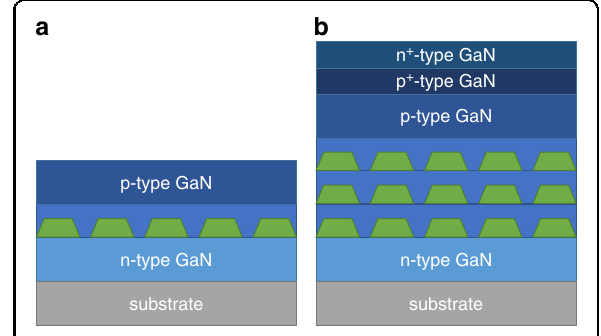
Fig. 2 Schematics of simpli fi ed device structures featuring InN QD active regions. A structure with a single layer of InN QDs is shown in ( a ) and a structure with three layers of InN QDs with a tunnel junction is shown in ( b